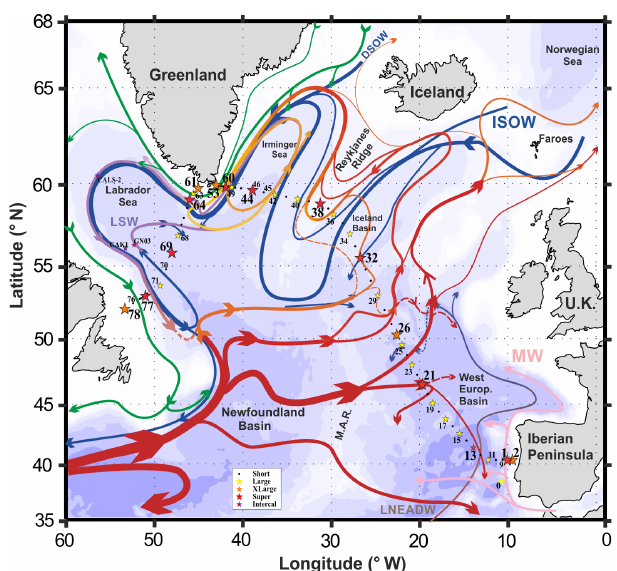
Figure 1. Schematic diagram of the mean large-scale circulation adapted from Daniault et al. (2016) and Zunino et al. (2017). Bathymetry is plotted in color with color changes at 100 and 1000m and every 1000m below 1000m. Black dots represent the Short sta- tion, yellow stars the Large ones, orange stars the XLarge ones, and red stars the Super ones. The main water masses are indicated: Den- mark Strait Overflow Water (DSOW), Iceland–Scotland Overflow Water (ISOW), Labrador Sea Water (LSW), Mediterranean Water (MW), and lower North East Atlantic Deep Water